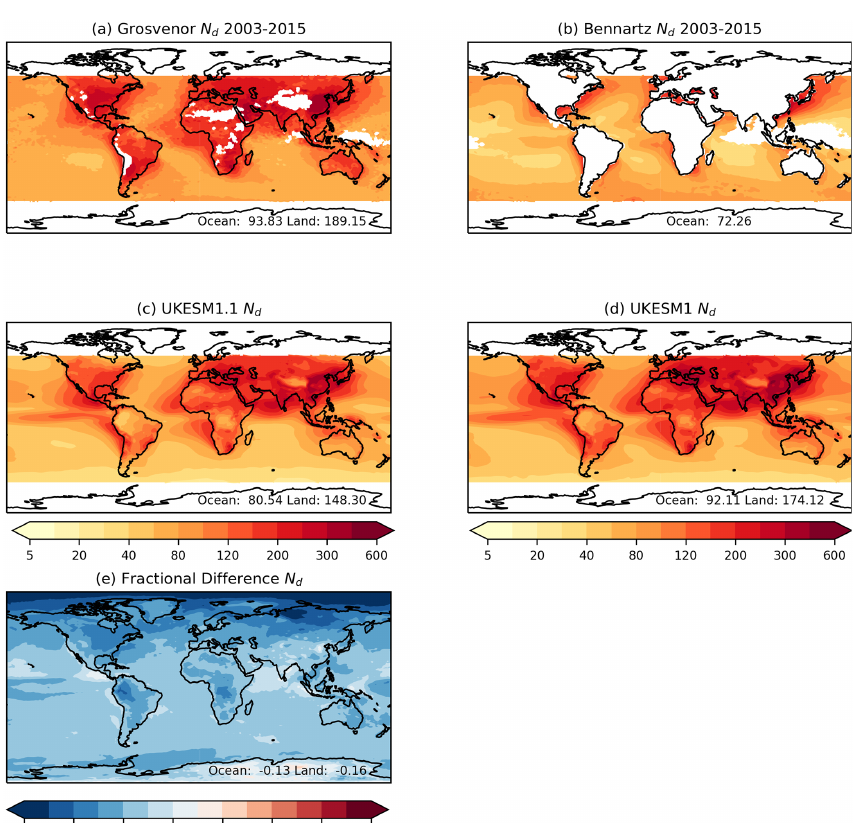
Figure 9. Observed and simulated annual mean cloud droplet number concentration at the cloud-top N d (cm − 3 ), from (a) Grosvenor et al. (2018), (b) Bennartz and Rausch (2017) satellite products and simulated N d from (c) UKESM1.1 and (d) UKESM1. (e) UKESM1.1 − UKESM1 N d fractional difference. The mean ocean and land N d values are displayed in the